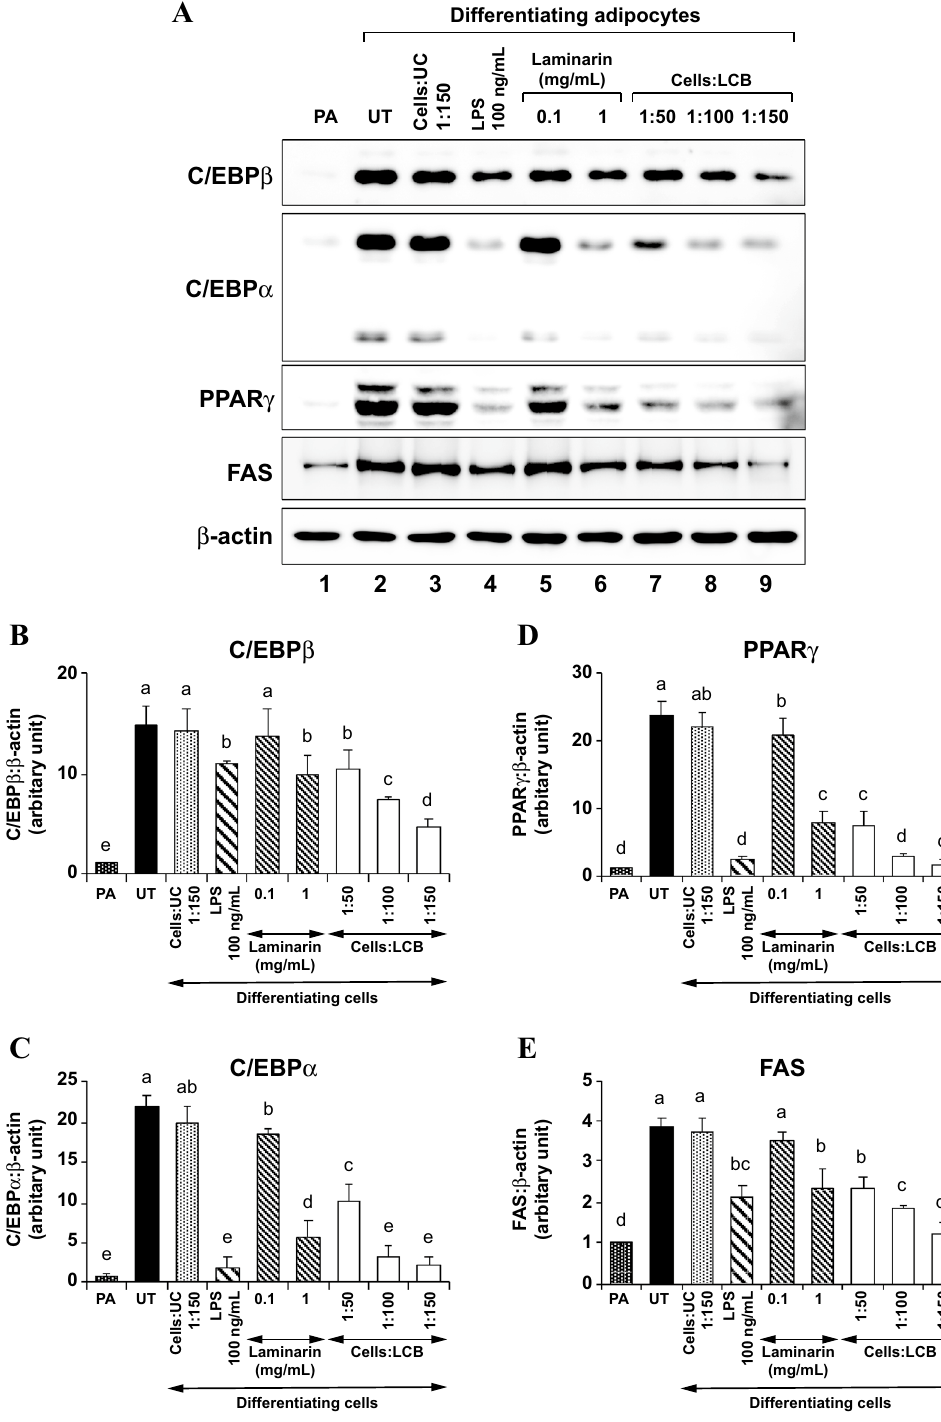
Figure 3. LCB inhibits the expression of key adipogenic transcription factors and enzymes in differentiating 3T3-L1 adipocytes in a dose-dependent manner. (A) shows a representative Western blot data set performed using anti-C/EBPβ, anti-C/EBPα, anti-PPARγ, anti-FAS, and anti-β-actin. The D/A medium, which starts adipogenesis, was added to 3T3-L1 preadipocytes without or with uncoated beads (UC) at the ratio of 1:150 cells:UC, 100 ng/mL LPS, soluble laminarin at 0.1 and 1 mg/mL, and an increasing amount of LCB (1:50, 1:100, and 1:150 cells:LCB). UC and LPS serve as a negative and positive control for the inhibition of adipogenesis, respectively. The treatment was performed for 2 days before harvesting the cells for the Western blot assays. (B–E) show the expression of C/EBPβ, C/EBPα, PPARγ, and FAS proteins, respectively. The protein expression is calculated from the protein:β-actin ratio from each treatment and expressed as the relative ratio in respect to the ratio from preadipocytes data shown in lane 1 in (A)